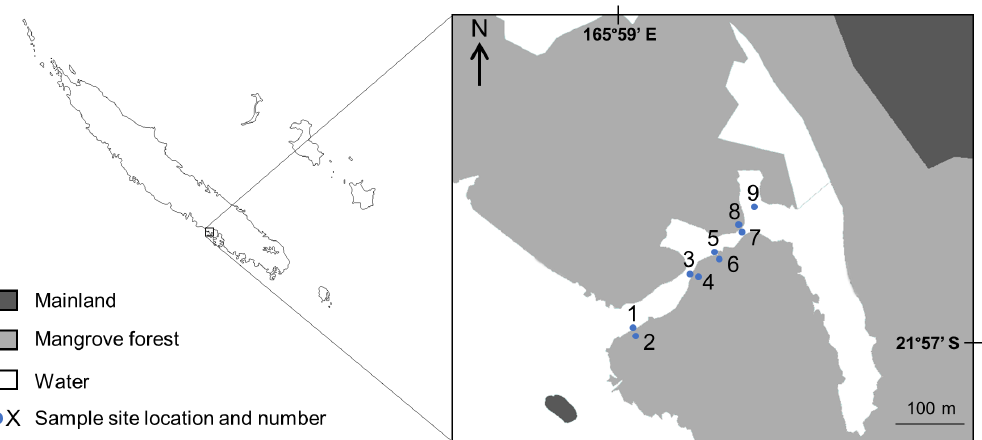
Figure 1. Map of the study system in Bouraké, South Province, New Caledonia. The nine study sites sampled from 21 February to 1 March 2017 are indicated by their corresponding numbers. Light grey areas represent mangrove forest, dark grey areas represent mainland and white areas represent